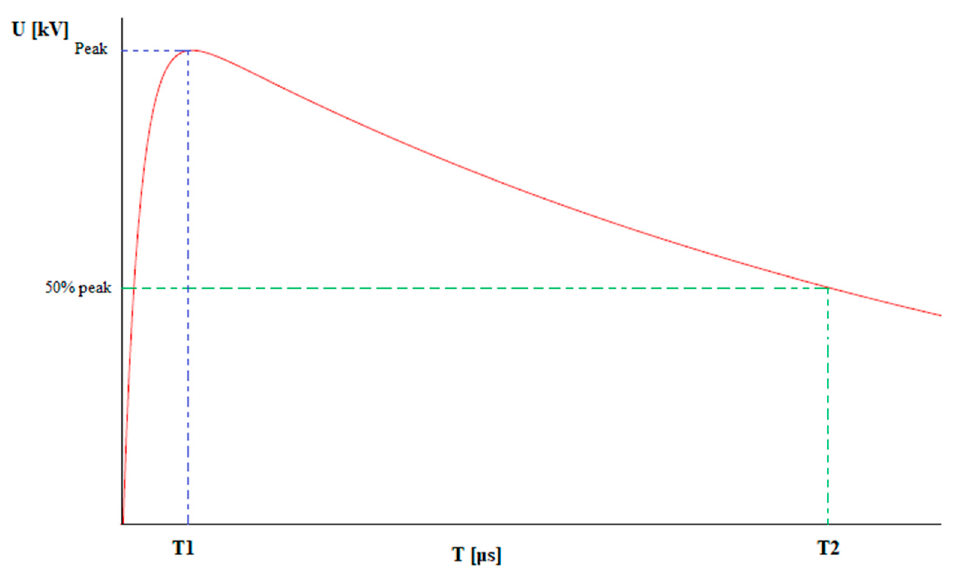
Figure 1. Idealized WF4 voltage waveforms T1 = 6.4 µs ± 20%, T2 = 69 µs ± 20%) [13,15].